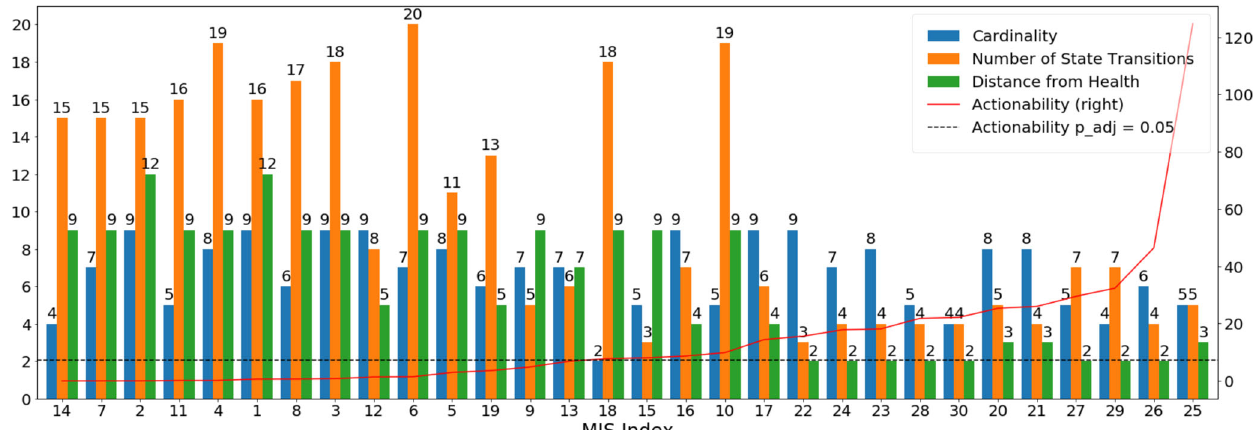
Fig. 1 Suitability of optimal target sets for drug repurposing. A quantitative ranking of 30 model-predicted idealized interventions of various cardinality (green bars), length of response trajectory or ef fi ciency (orange bars) and distance from optimal outcome (blue bars) as a function of their actionability (red line) or potential for translation into clinic using repurposing of currently available drugs. Only 16 of the initial 30 solution sets are signi fi cantly more accessible (empirical null distribution P < 0.05; A > A crit, P = 0.05 ~7.25) to repurposing than a random MIS solution set (dashed blue